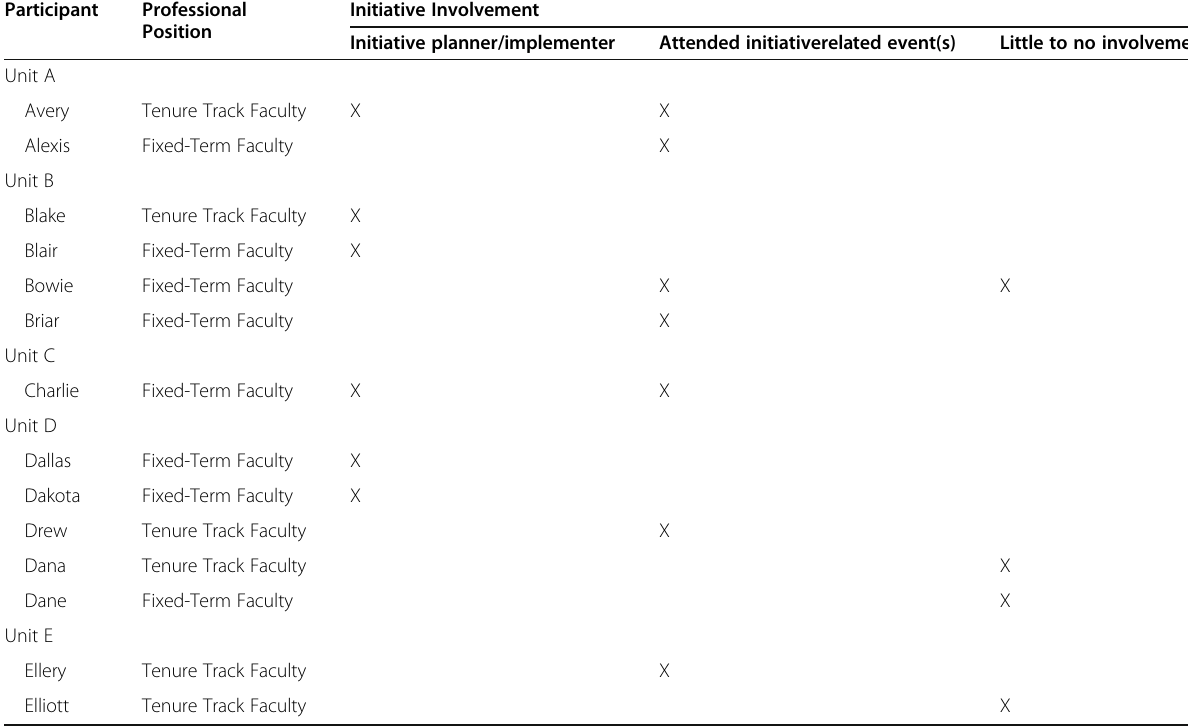
Table 1 List of Participants, Participants ’ Professional Positions, and Participants ’ Involvement in the Initiative